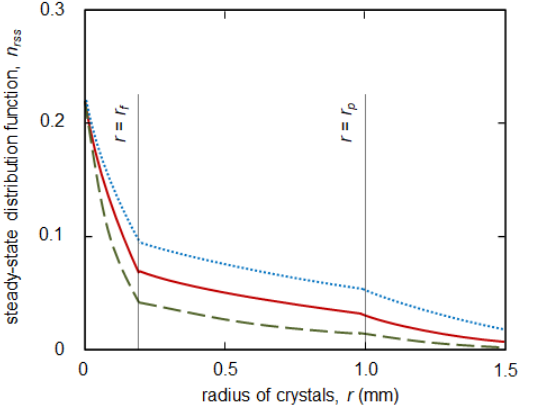
Figure 2. The steady-state particle-radius distribution n rss = n ss / Λ for different nucleation and growth rate constants: b = g = 1 (solid line); b = 1, g = 1.5 (dashed line); b = 1.5, g = 1 (dotted line). Parameter values for a laboratory-scale KCl crystallizer are [22]: r f = 0.2 mm, r p = 1 mm, R 1 = 5, R 2 = 2, q = 0.05 L/min, V = 10.5 L, k b = 2.05 · 10 − 2 L 3 /(min mol 4 ), k g = 9.15 · 10 − 2 mm L/(min mol), ρ = 1989 gr/L, M = 74.551 gr/mol, k v = 0.1112, c s = 4.038 mol/L and c ss = 4.091 mol/L for the solid